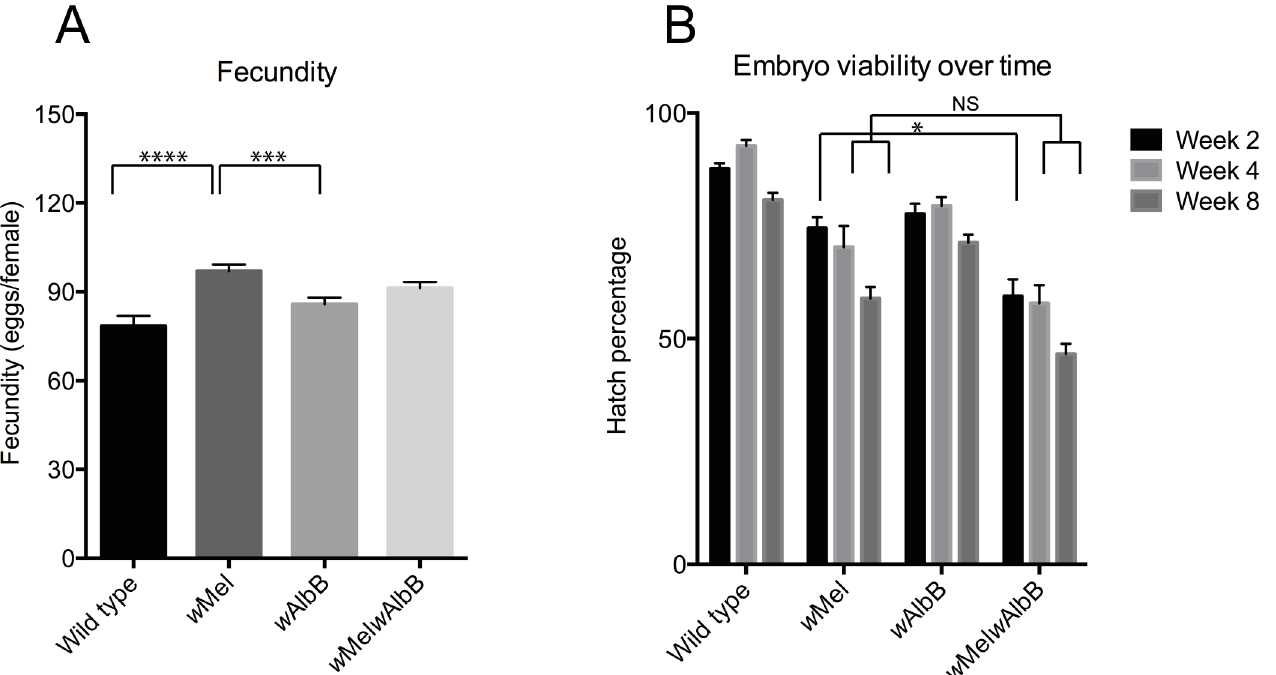
Fig 3. Fecundity and fertility of Wolbachia -infected Ae . aegypti . (A) Fecundity of Wolbachia -infected and wild type females as determined by mean egg production from individual female mosquitoes. Statistical significant differences between all data sets were determined using a Kruskal-Wallis test with Dunn ’ s multiple comparisons test. Significant differences are indicated by **** (p < 0.0001) or *** (p < 0.001) and standard error of the mean is indicated. Non-significant differences are not indicated. (B) Mean hatch rate of Wolbachia -infected and wild type females as determined by percentage of eggs hatching over time. Statistical differences between all data sets were determined using a two-way ANOVA with Tukey ’ s multiple comparisons test. For simplicity, only the comparison between w Mel (current release strain) and w Mel w AlbB is shown in the figure. A small but significant difference between the hatch rates for w Mel and w Mel w AlbB was observed after two weeks ( * , p = 0.0159), however, no significant differences could be found at the 4 and 8 week time points. All experiments were conducted using mosquitoes from G8 of the superinfected line and standard error of the mean is indicated.